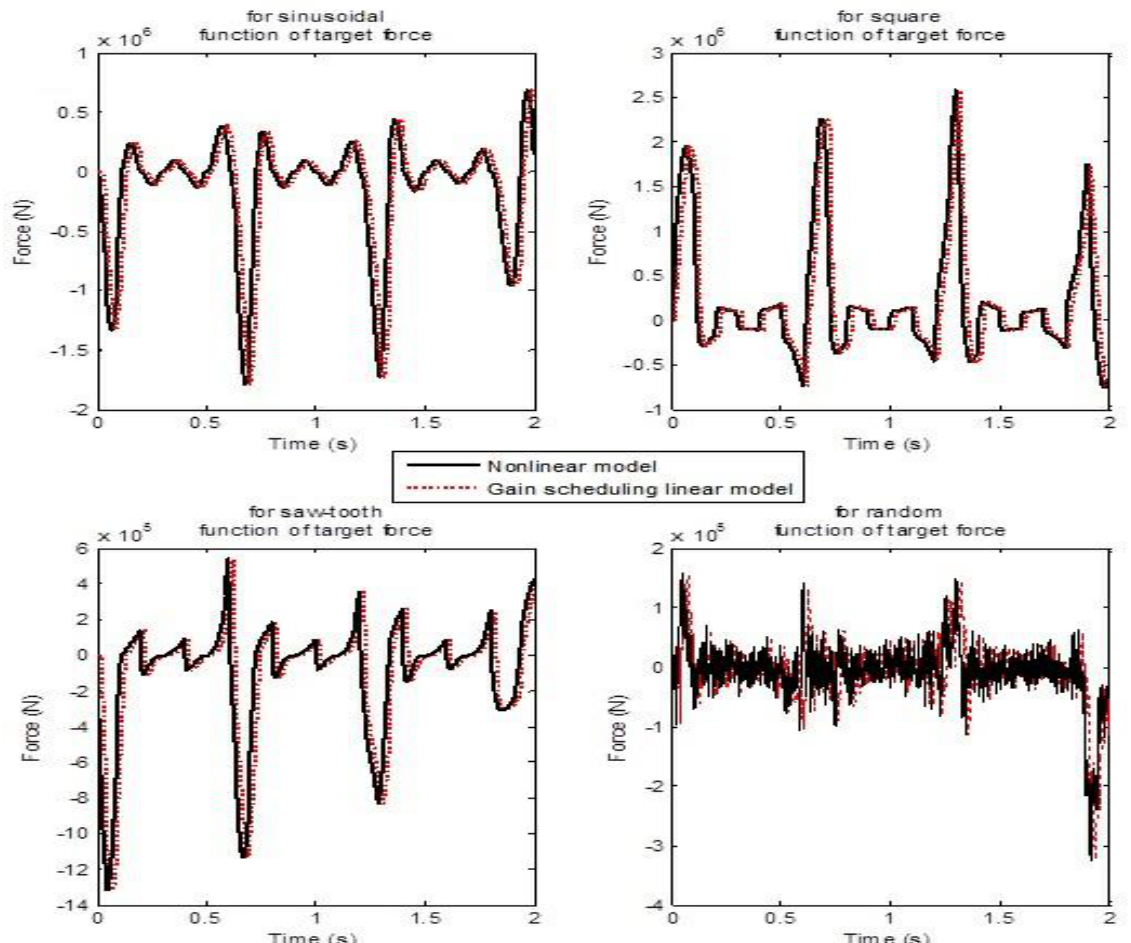
Figure 4. Responses of the models for different